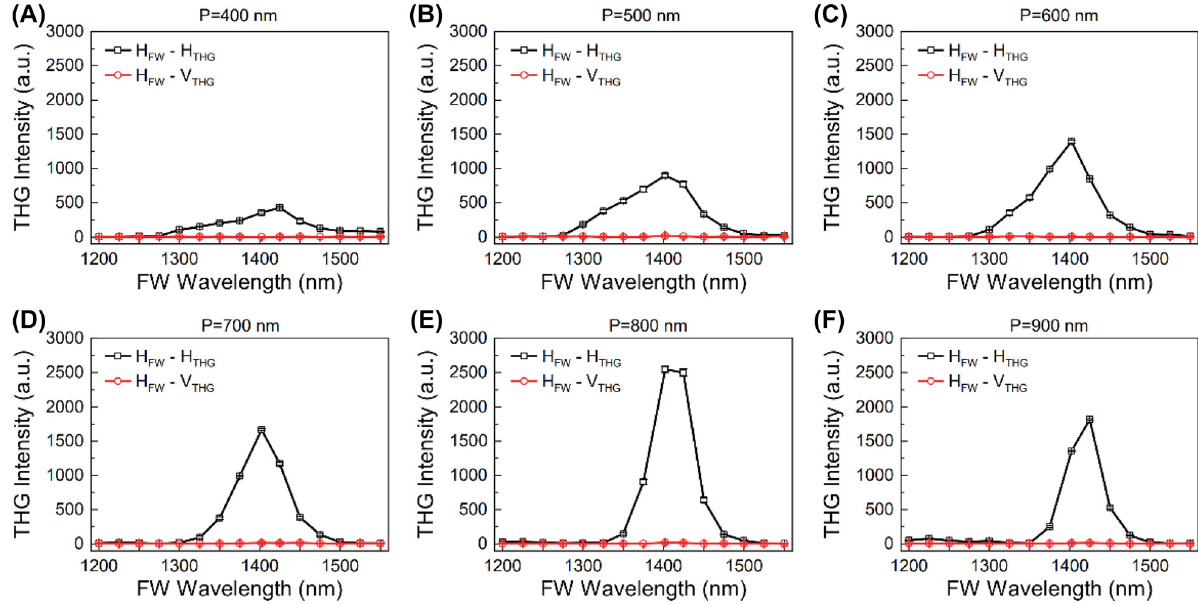
Figure 3: Measured wavelength dependent THG responses of the gold/ α -Si hybrid metasurfaces with different periods. ‘ H FW -H THG ’ and ‘ H ’ represent the polarization states of the FW and the measured THG waves (H: horizontal polarization; V: vertical polarization). FW -V THG (A) P = 400 nm, (B) P = 500 nm, (C) P = 600 nm, (D) P = 700 nm, (E) P = 800 nm and (F) P = 900